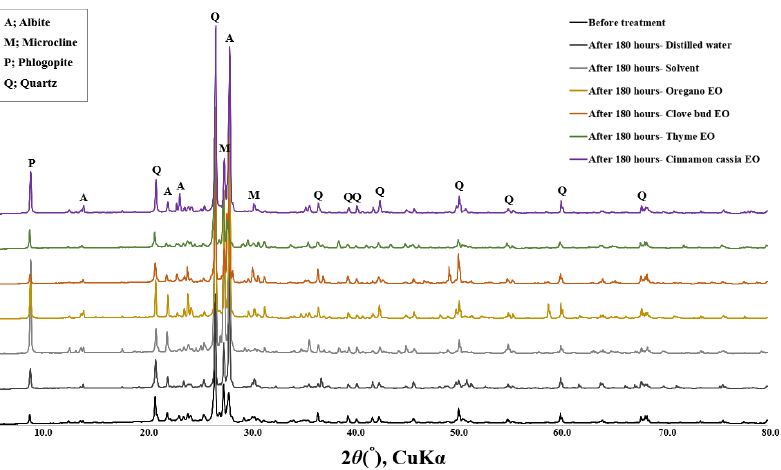
Figure 4. X-ray diffraction analysis of granite specimens before and after treatment with 10% low- concentration essential oils.